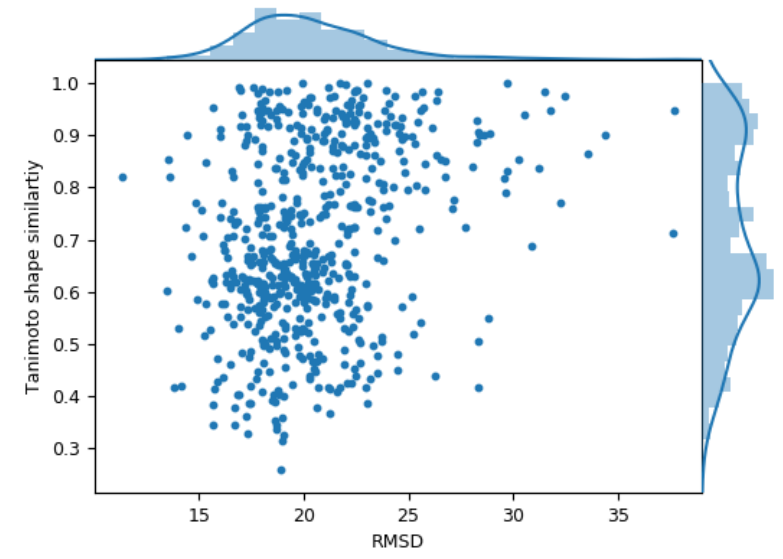
Figure 3. MCL shape similarity versus target RMSD. The scatter plot reports pairwise comparisons of MCL complexes containing proteins from different classes. Each dot represents a pair of complex structures. The shape similarity of the bound conformations of the MCL in both complexes is plotted against the alpha carbon RMSD of the protein structures on the basis of best possible rigid body superposition. In addition, the value distributions along the horizontal and vertical axes are represented as histograms.